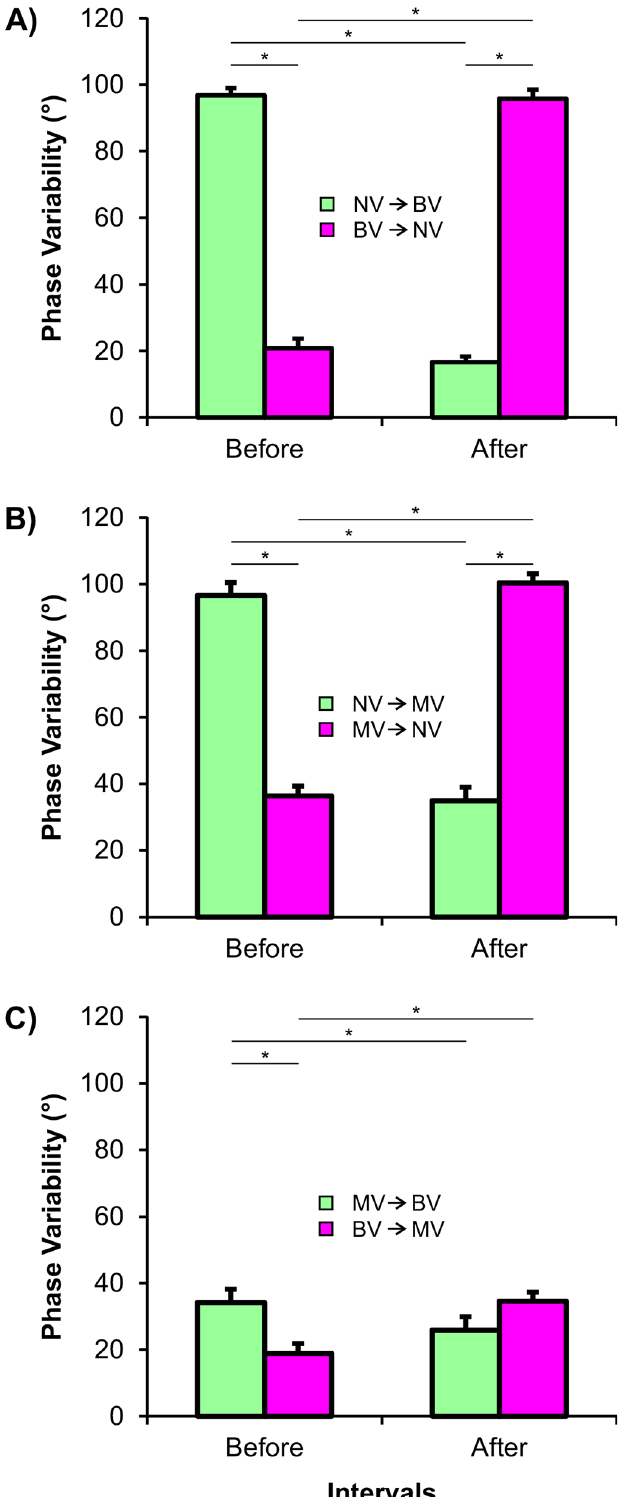
Fig 5. Mean and standard error for phase variability in the different visual transitions. A) Binocular and no vision transitions. B) Monocular and no vision transitions. C) Binocular and monocular vision transitions. Horizontal lines indicates pairwise differences ( * p (cid:3) 0.05) [BV: binocular vision | NV: no vision | MV: monocular vision]. doi:10.1371/journal.pone.0150158.g005 PLOS ONE | DOI:10.1371/journal.pone.0150158 March 3,